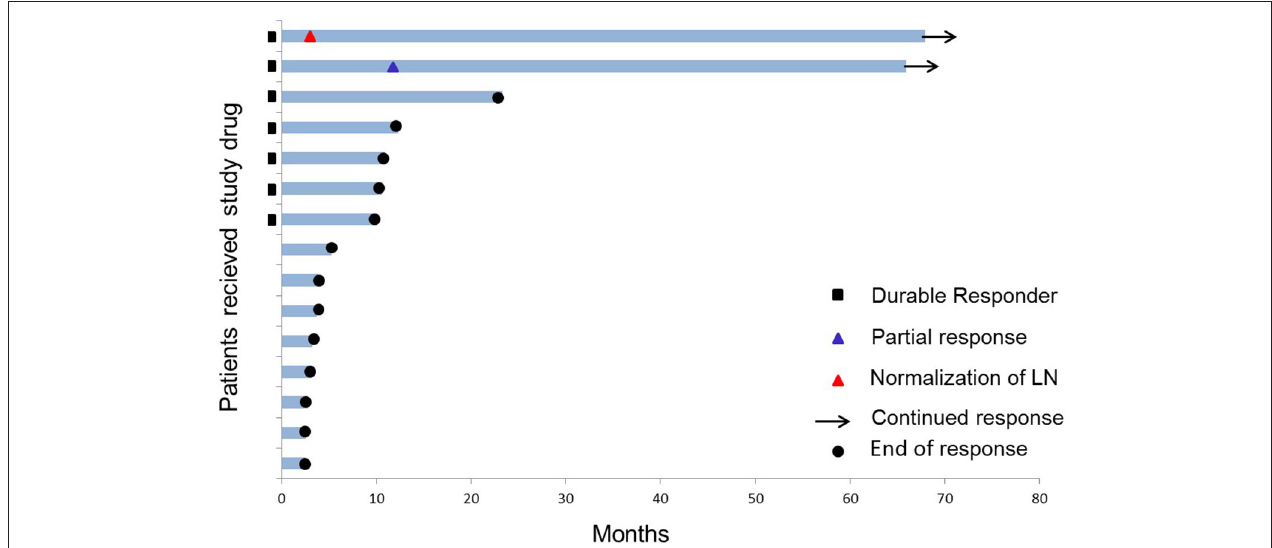
FIGURE 1 | Swimmer plot of the 15 stage III–IV HLA-A2 + NSCLC patients who received study drug (IDO peptide vaccine). Two of 15 patients are long-term responders (as of 6 years after the 1st vaccine). Durable response is defined as > 8.5 months clinical treatment